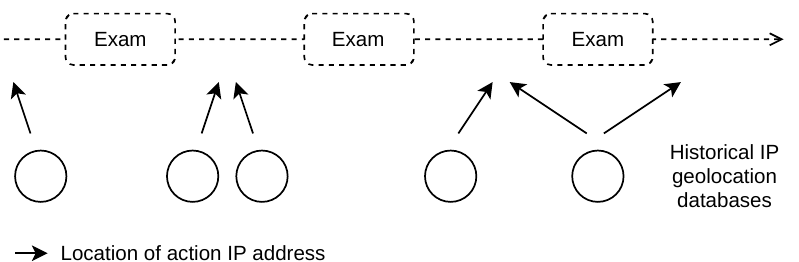
Figure 7. IP geolocation of student’s actions. Historical databases are used to eliminate errors due to date